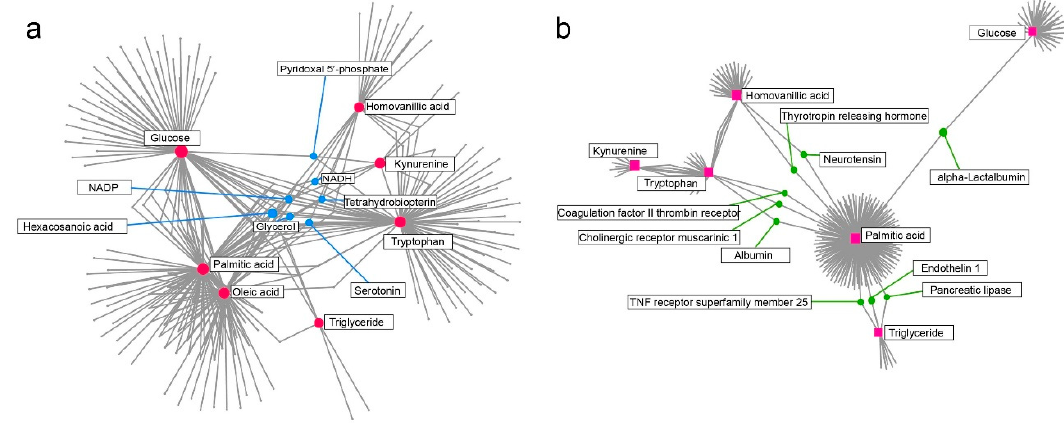
Figure 7. KEGG global metabolic network of key metabolites. ( a ) Metabolite-metabolite interac- tion network analysis of target metabolites. Known metabolites are presented as red nodes and unknown metabolites are presented as blue nodes. Correlations of metabolites are denoted as edges. NADP = nicotinamide adenine dinucleotide phosphate; NADH = nicotinamide adenine dinucleotide. ( b ) Gene-metabolite interaction network analysis of the target metabolites. Known metabolites are presented as pink nodes and key genes are presented as green nodes. Correlations are denoted as